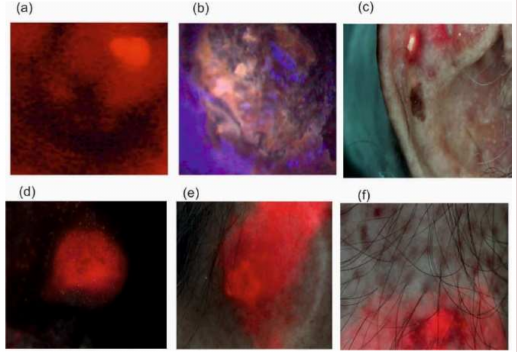
Figure 13. Fluorescent images of ( a ) vaginal, ( b ) cervical, ( c ) basal cell carcinoma of head, ( d ) squamous cell carcinoma of nose, ( e ) actinic keratosis of skin, ( f ) after ALA